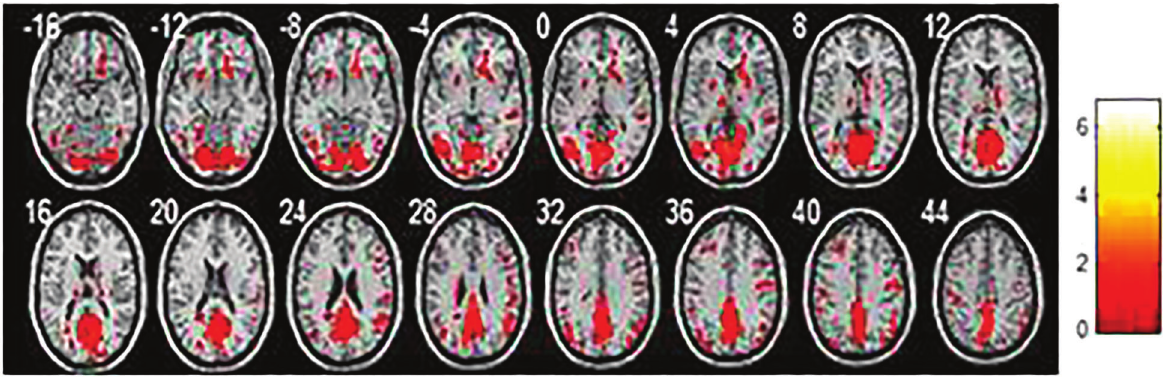
Figure 1. Average regional homogeneity in the normal elderlies. Each image represents a slice, with 4 mm distance from the other. 0 is the 0 position of space coordinates. The color bar indicates energy intensity.